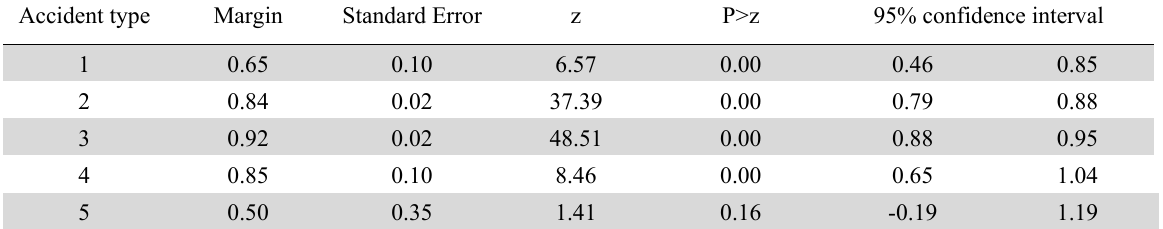
Quantile 1 dead people by accident type Accident type